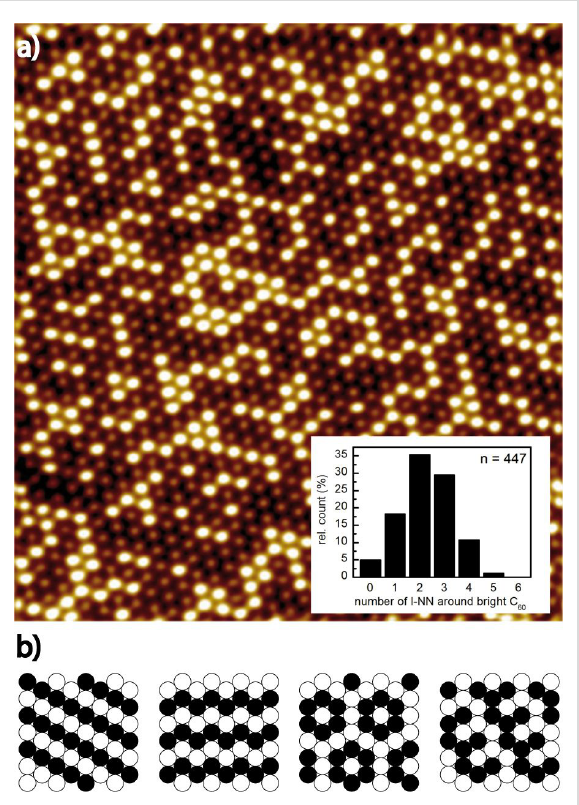
Figure 2: (a) Filtered STM image (30 × 35 nm 2 ) to highlight the dim and bright contrast of the C 60 molecules in a disordered R30° domain ( U bias = 0.68 V, I T = 0.11 nA ; sample A2). Inset: histogram of the number of like next neighbors (l-NN) around bright C 60 molecules. (b) Characteristic structure elements observed in the disordered ground state of frustrated Ising systems: ideal line, kinked line, pinwheel and comb